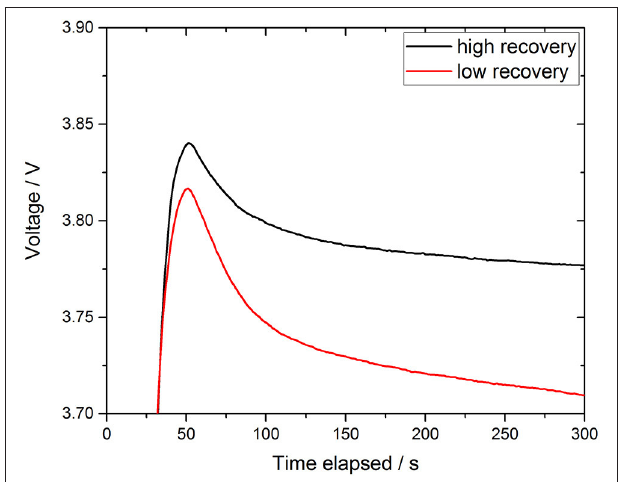
FIGURE 8 | Raw signal during the 5min waiting period to allow complete mixing as well as Fe(III) reduction and complexation with FZ. Data points with a high (September 18th, noon, black line) and a low recovery (September 14th, noon, red line) are